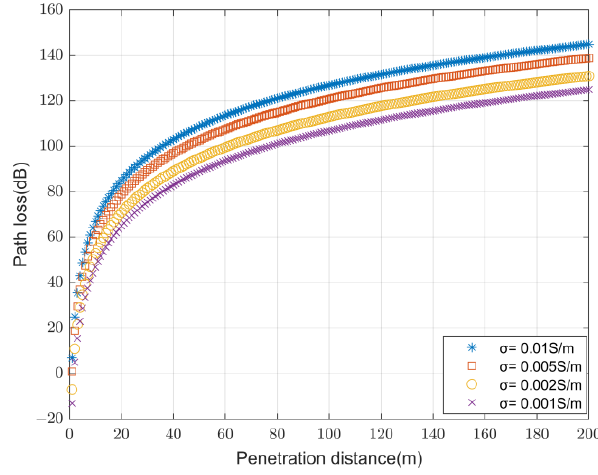
Figure 4. Relationship between the path loss and penetration distance.